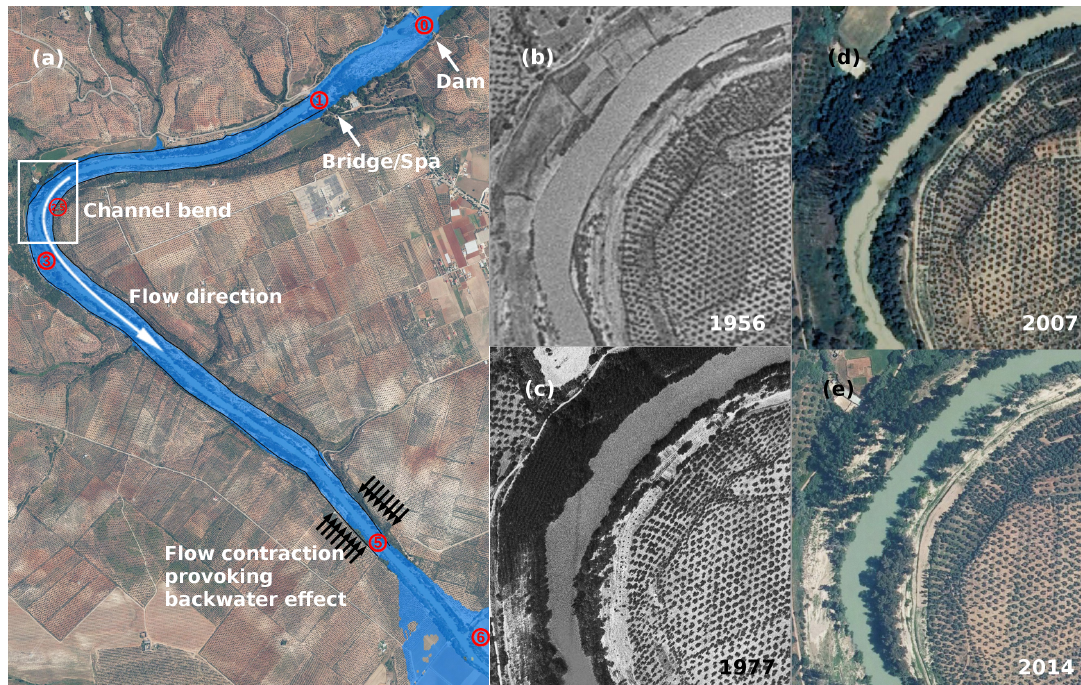
Figure 4. ( a ) Blue colour represents the inundated area obtained in the numerical simulation for the water discharge Q = 1400 m 3 · s − 1 with Manning’s coefficient n = 0.05 s · m − 1/3 . Numbers show the location and the distance to the dam (in km) of the main paleostage indicators (PSIs). The black lines highlight the slackwater deposits of fine sediments found out along the riversides in fieldworks as well as in the 2014 orthophoto; ( b – e ) Sequence of orthophotos in the bend (white box in panel ( a )) showing the states before/after river regulation (1956/1977) and snapshots before/after modern floods (2007/2014). Note the absence of riparian vegetation in 1956 (panel ( b )), the proliferation of riparian vegetation after river regulation (panel ( c )) which started in 1962 with Marmolejo dam and prevails up to present days (panels ( d , e )), and the presence of slackwater deposits in 2014 (panel ( e )) as a consequence the April 2013